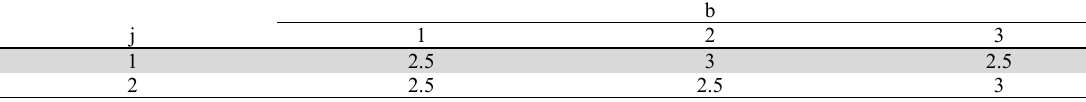
Maximum Capacity of Plants (CP b j ) (kg×10 3